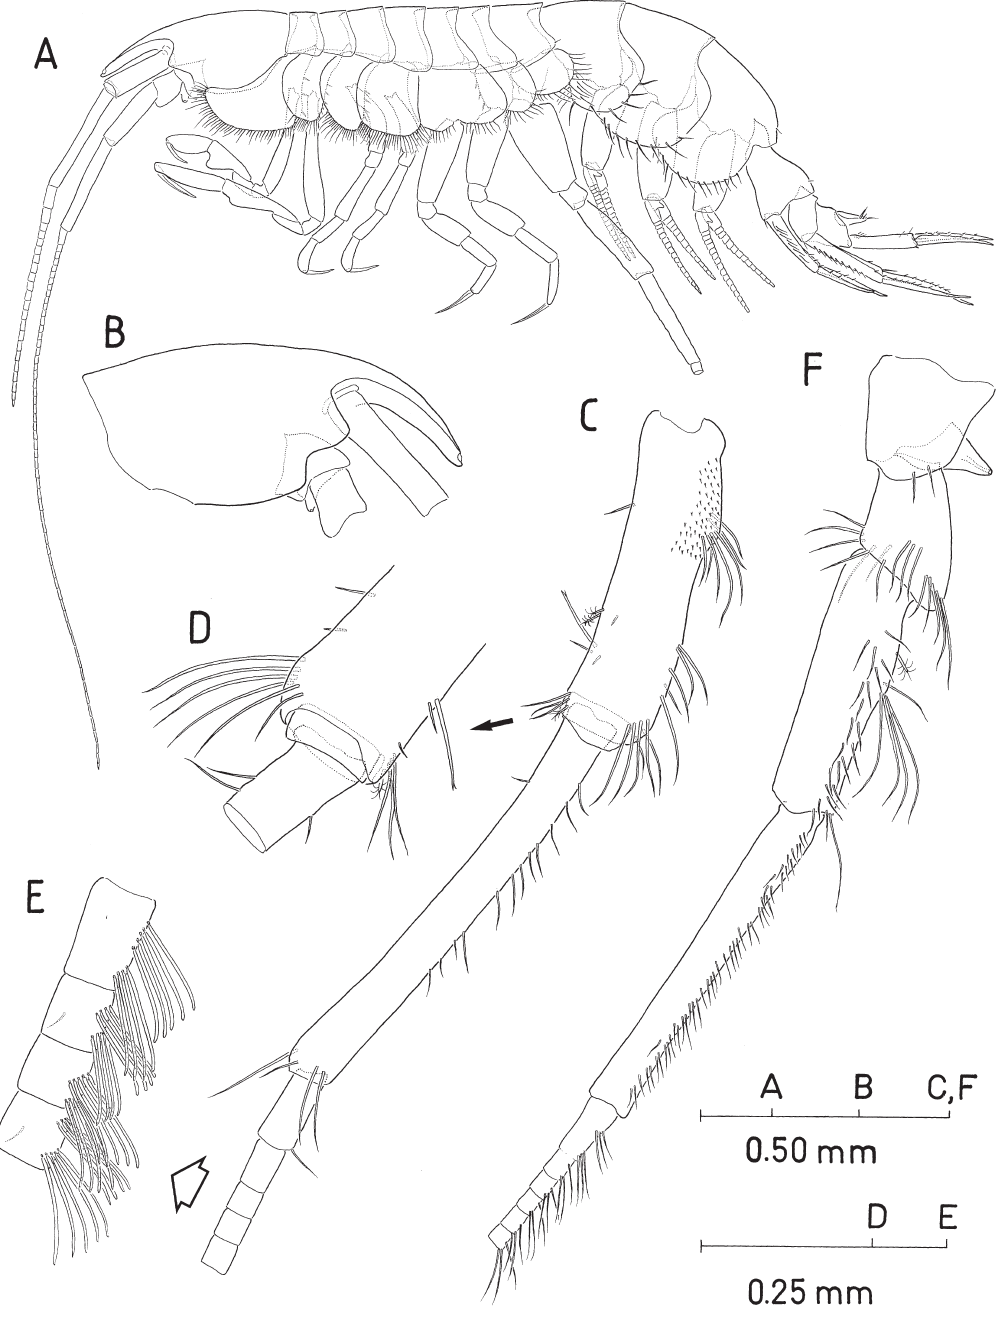
F IG . 2. – Bathymedon longirostris sp. nov. A, (cid:1) body, lateral (mouthparts and coxal gills omitted); B, (cid:2) head, lateral; C, proximal part of (cid:1) left first antenna, medial; D, detail of reduced second segment of peduncle of (cid:1) first antenna, lateral; E, detail of 4 proximal segments of